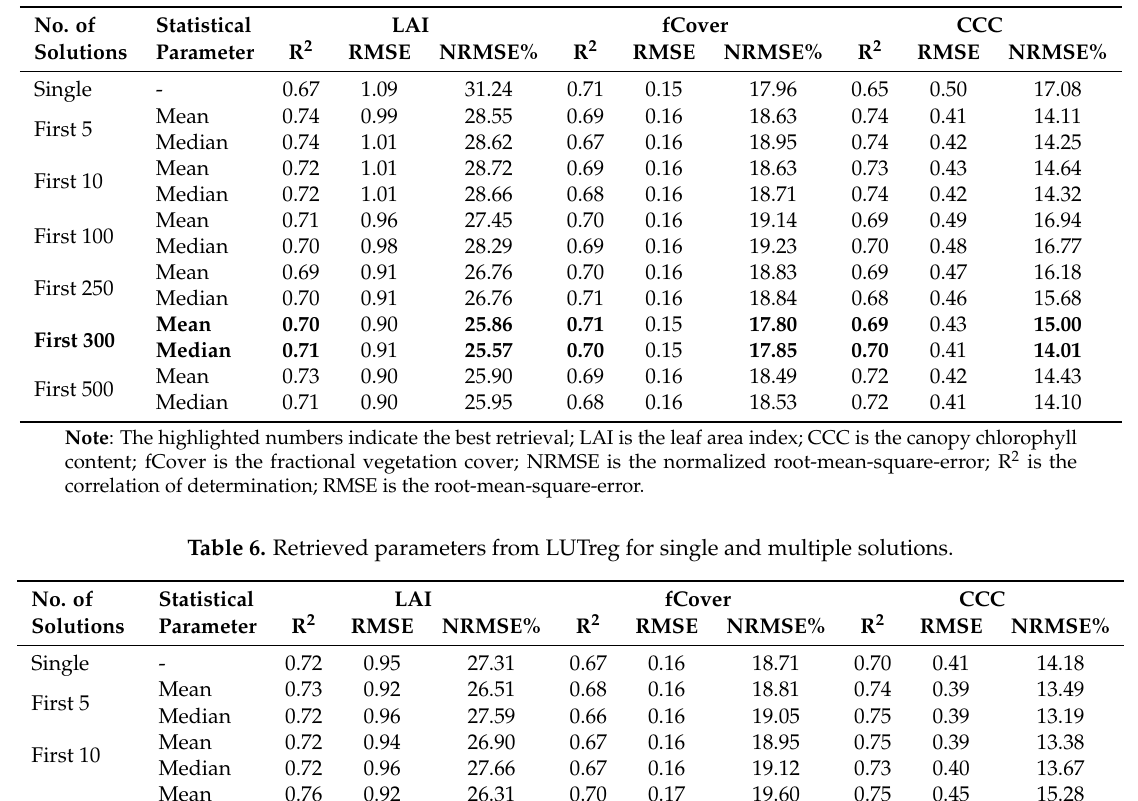
Table 5. Retrieved parameters from LUTstd for single and multiple solutions.